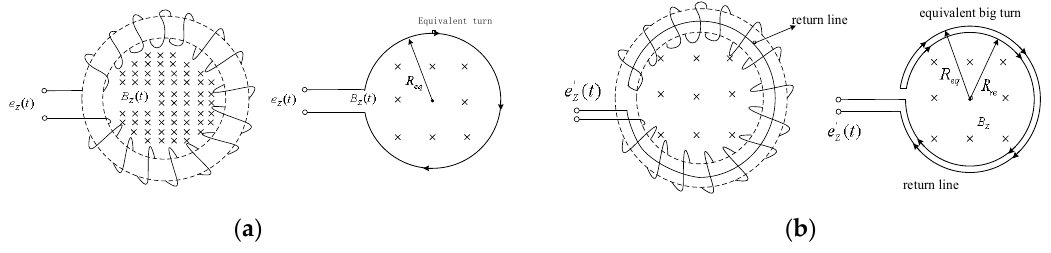
Figure 5. The return line of Rogowski coil. ( a ) Equivalent large turn without return line; ( b ) Rogowski coil with the return line.